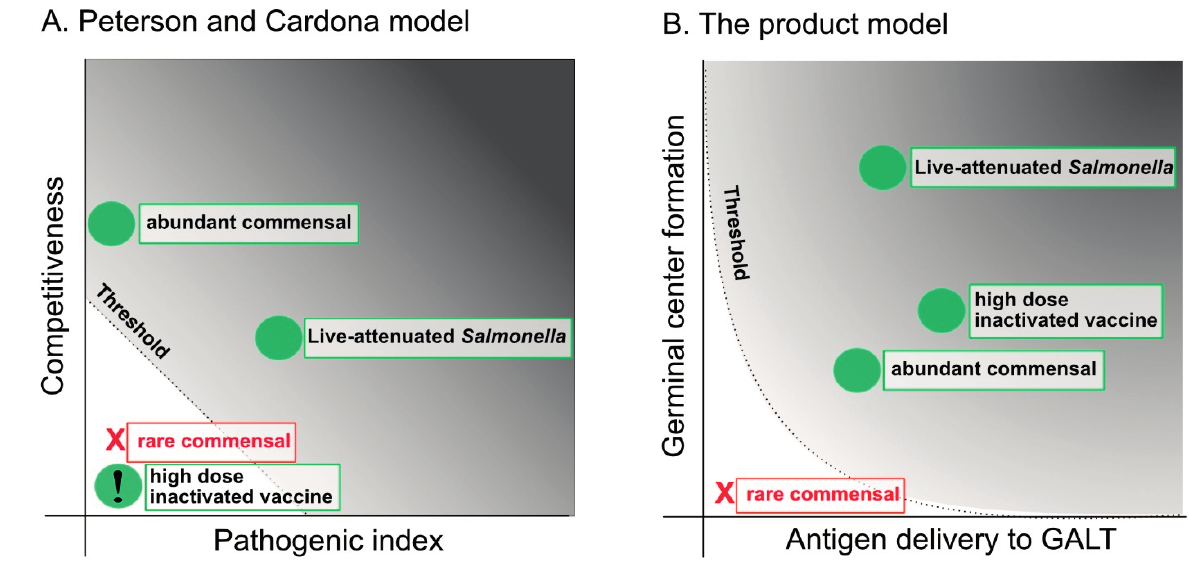
Figure 1. Theoretical models of high-affinity sIgA induction. ( A ) Theoretical depiction of Peterson and Cardona’s basic summation model based on competition with the microbiota and pathogenicity versus ( B ) one based on GALT entry and germinal center formation. Gray shading indicates the areas where high-affinity sIgA responses would be expected to be elicited. Entities known to elicit strong high-affinity sIgA responses are shown with green circles. “!” denotes entities that are incompatible with the model’s predictions. Entities eliciting poor or no antibody responses are shown with a red “X.” High-dose inactivated vaccine behavior can only be explained by the adapted model ( B